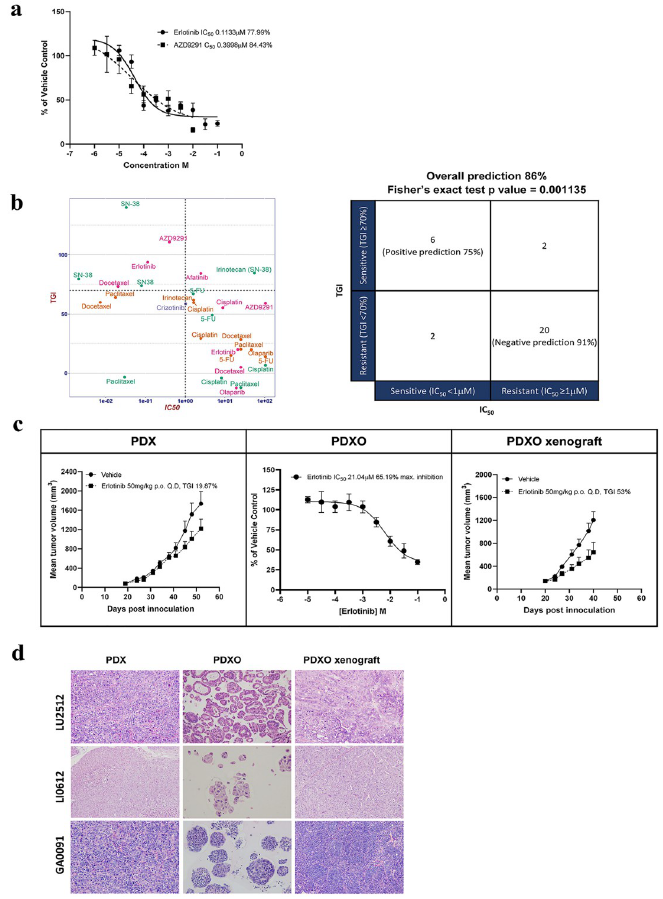
Fig 3. High correlation between in vitro PDXO and in vivo PDX pharmacology. a) NSCLC LU1235 (EGFR activation exon-19 deletion) PDXO dose response (% of vehicle control ± SEM) to erlotinib and AZD9291 to determine absolute IC 50 values and maximum inhibition; b) Matched PDXO in vitro and PDX in vivo responses across 30 PDXO/PDX paired datasets (left) to determine the predictive power of PDXO for PDX response. The criterion for in vitro and in vivo sensitive/responsive or resistant/non-responsive is shown on the right panel with number of datapoints in each category to determine the predictive values and correlation analysis by Fisher’s exact test (right). c) Growth and therapeutic response to erlotinib in NSCLC LU2512 (EGFR wildtype) PDX in vivo (mean tumor volume ± SEM with 5mg/kg IP weekly dose regimen for erlotinib, left), PDXO in vitro (middle, dose response curve of % of vehicle control ± SEM to determine absolute IC 50 values and maximum inhibition) and PDXO xenograft in vivo (TGI with 5mg/kg IP weekly dose, right). d) H&E staining of three models (top to bottom; lung cancer LU2512, liver cancer LI0612 and gastric cancer GA0019) grown as either PDX ( in vivo , 40x magnification, left), PDXO ( in vitro , 16x magnification, middle) or PDXO ( in vivo , 40x magnification, right).